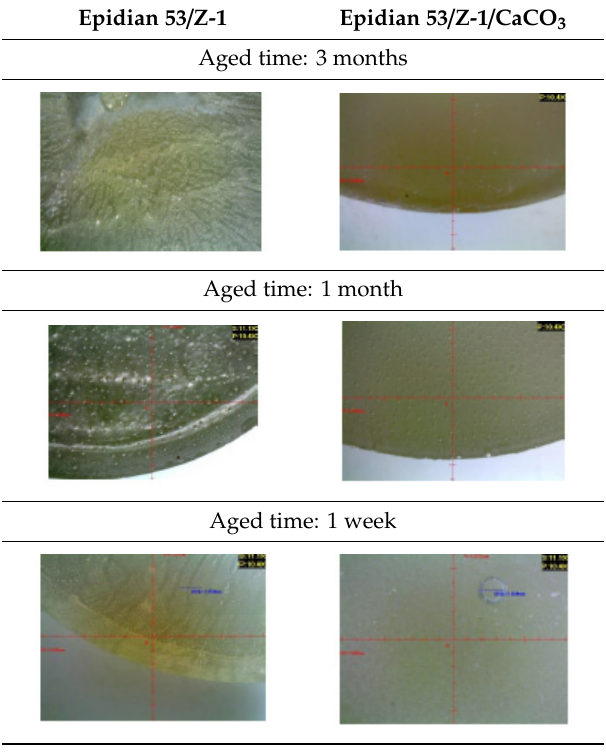
Table 7. Samples aged in double reference salinity environment.